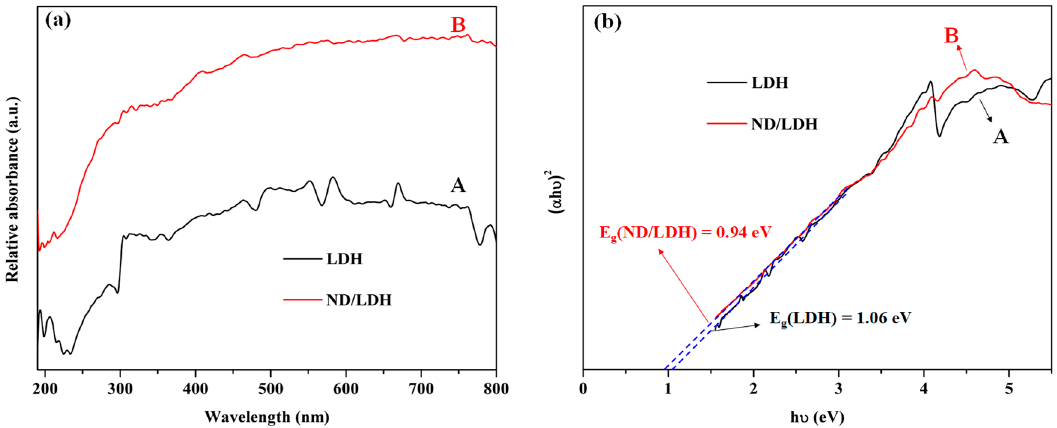
Figure 11. UV-Vis diffuse reflectance spectra (DRS) ( a ) and calculated the band gap (E g ) ( b ) of LDH ( A ) and ND/LDH ( B ).